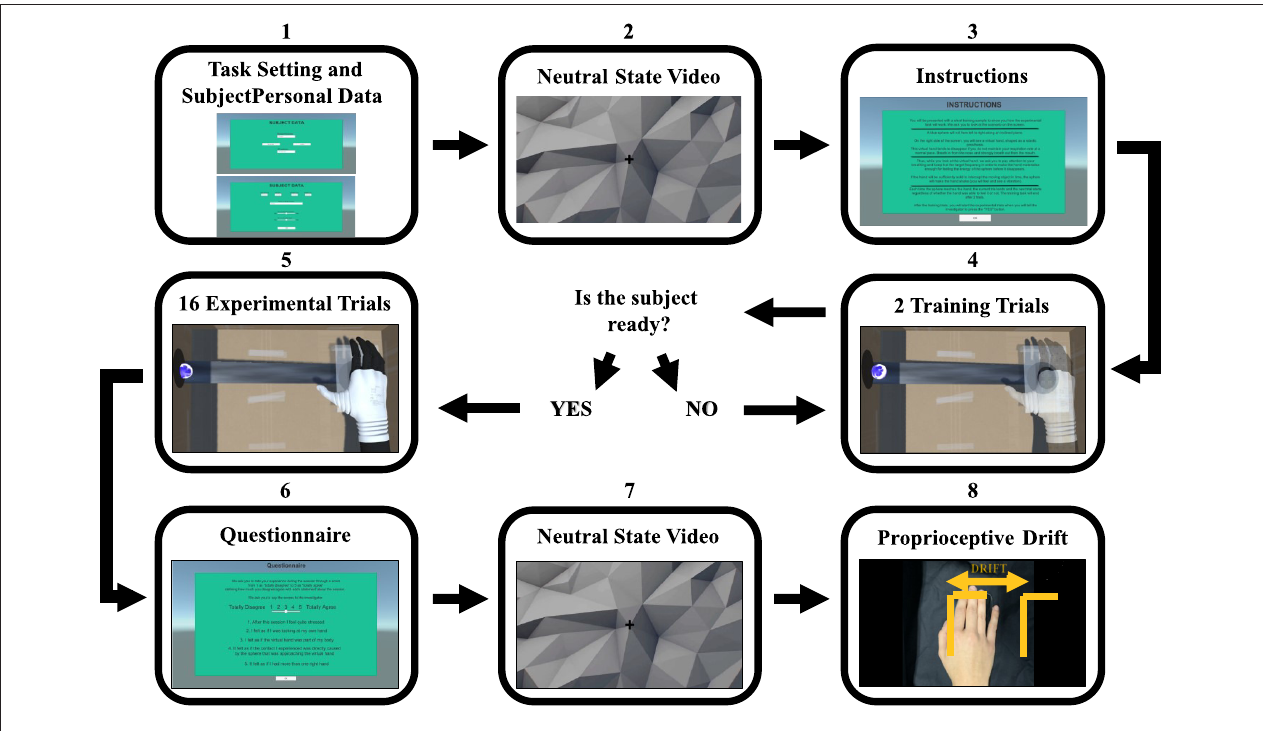
FIGURE 4 | Experimental